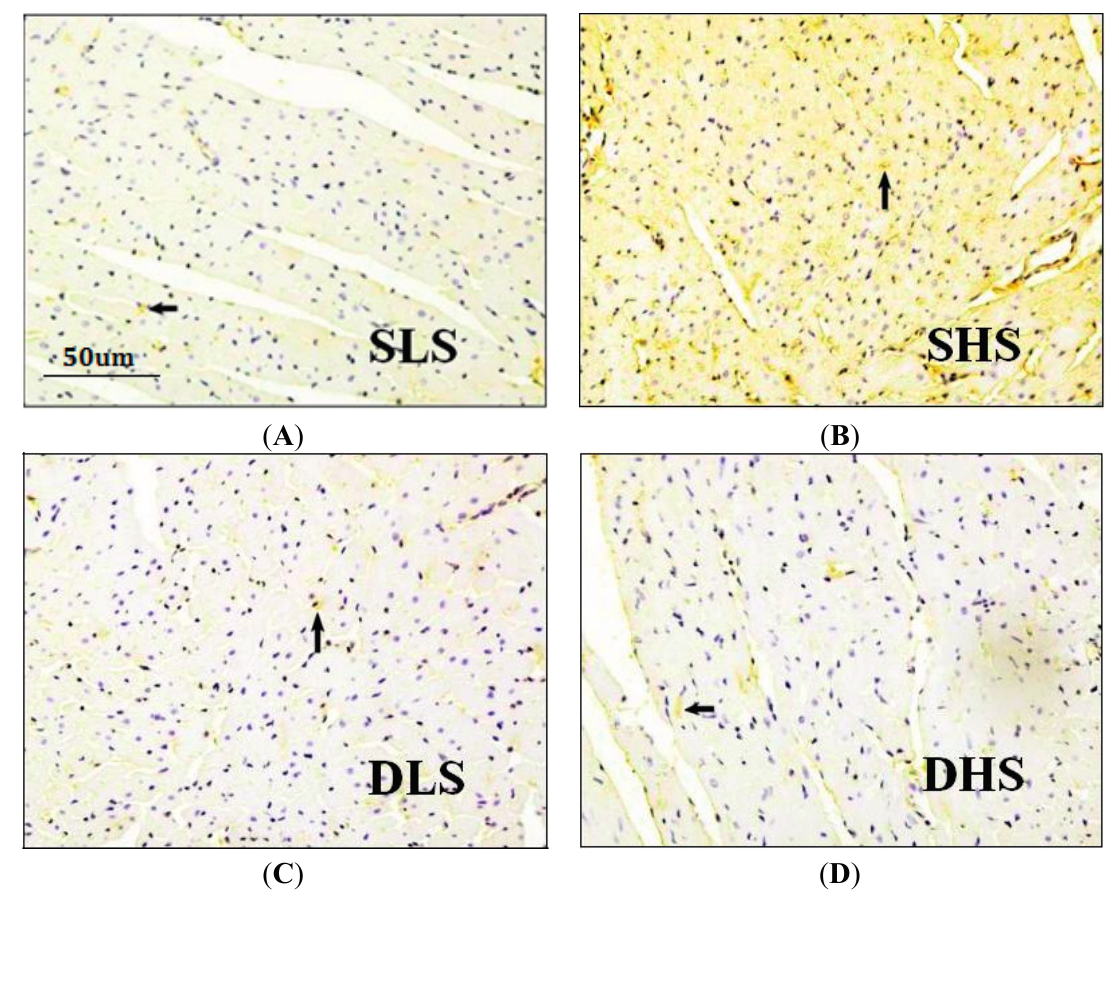
Figure 4. Micrographs of heart slices in the left ventricle (LV) of SS rats and SD rats. The myocardial CTGF expression was detected through immunohistochemical